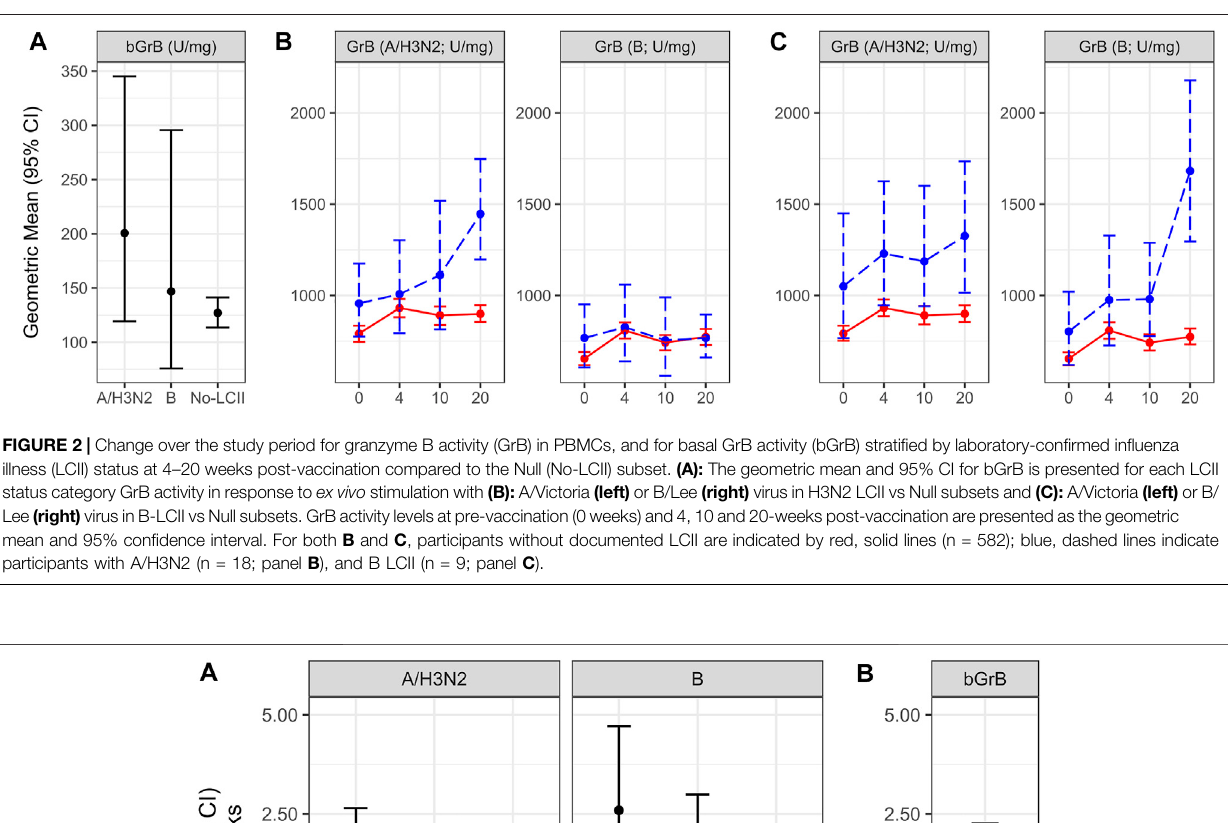
stimulation in B-LCII: 975 (722, 1357) vs No-LCII: 809 (766, 853) PBMC ( Figure 2C , right panel, Supplemental Table S2 ). Similar to the in fl uenza type-speci fi c response following natural infection with A/H3N2, B-LCII cases showed a signi fi cant increase in B/Lee-stimulated GrB activity compared to the No-LCII subset at 20-weeks post-vaccination; B-LCII: 1683 (1272, 2194) vs No- LCII: 774 (734, 815) ( Figure 2C , right panel; Supplemental Table S2 ; p < 0.001). Compared to the No-LCII subset, B-LCII cases